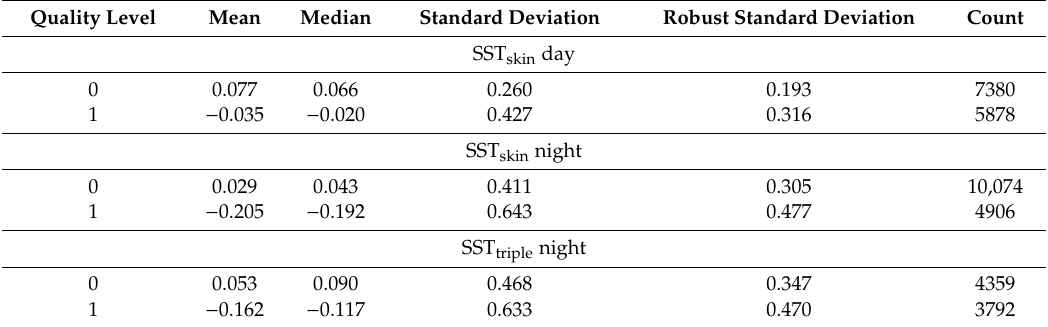
Table 6. Global statistics for VIIRS SST skin retrievals compared to SST skin derived from M-AERIs. Quality